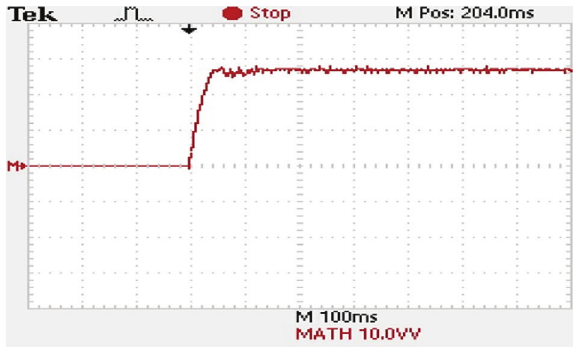
Figure 16: Experimental results for SMESC performance given uniform irradiance of 1000W/m 2 .